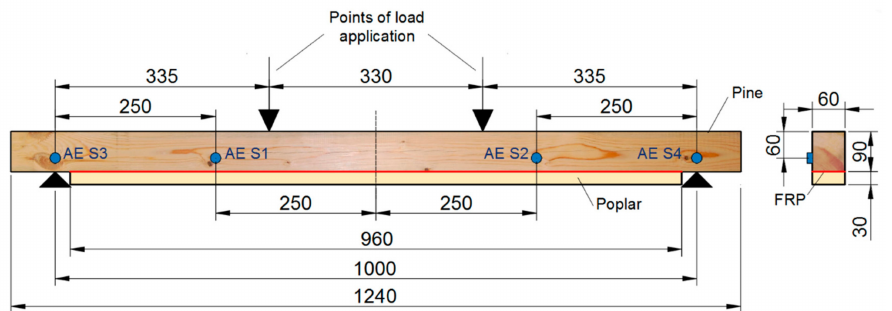
Figure 1. Experimental setup. Distances in mm.